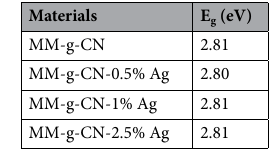
Table 5. Indirect band gap energy values (Kubelka–Munk function, Tauc spectra) from DRS spectra of MM-g-CN-n%